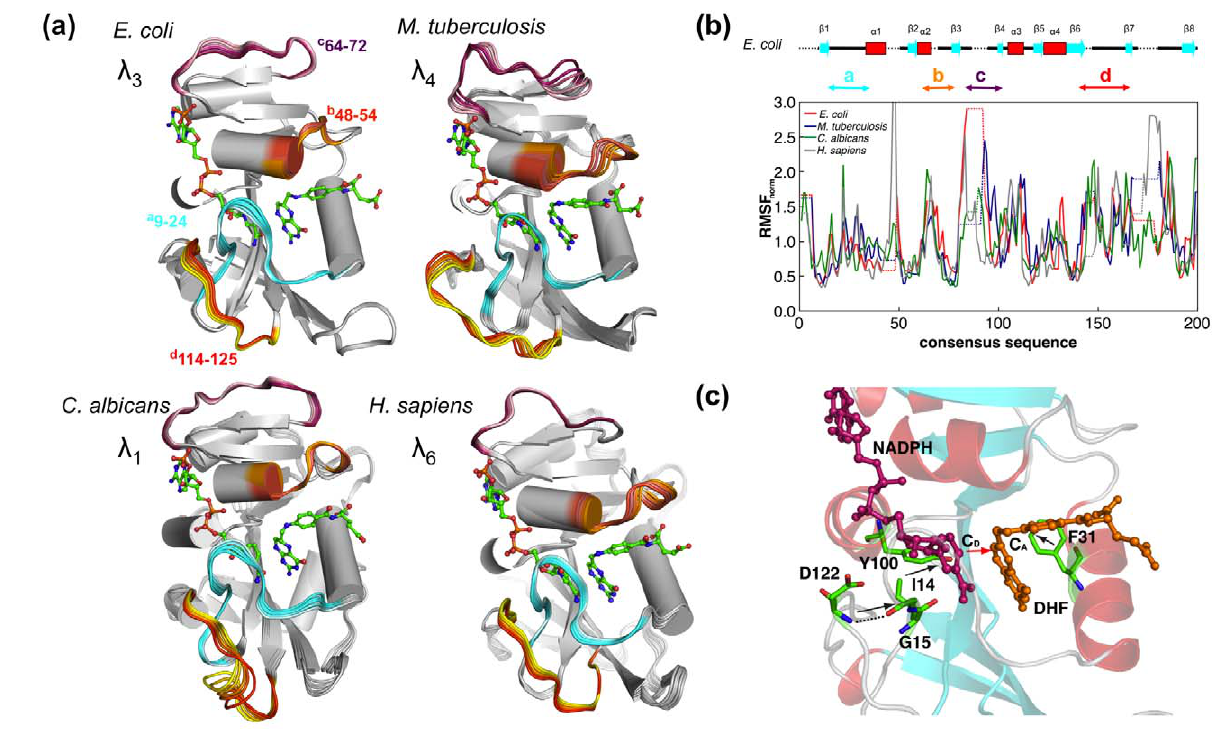
Figure 3. Conservation of reaction-coupled flexibility in enzyme DHFR across four species. (a) Slowest mode coupled to the hydride transfer catalyzed by these chromosomally encoded DHFRs shows large fluctuations in the same regions (near and away from the active-site) of the enzyme from four species. (b) Enzyme backbone flexibility depicted as normalized RMSF. (c) Conservation of the network interactions (black arrows) connecting the flexible regions as a part of the DHFR fold (only E. coli DHFR is shown). The red arrow indicates the catalyzed hydride transfer between C D and C A . The modes are depicted/colored and the RMSF is normalized similarly to the CypA results. See legend of Figure 1 for further details.